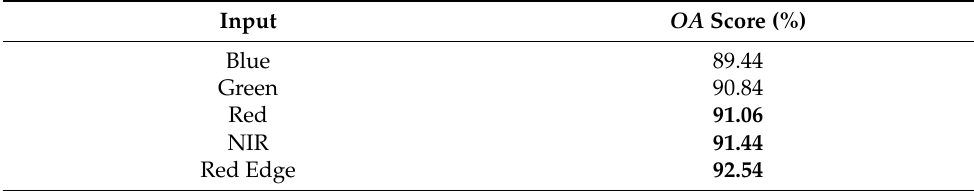
Table 12. Performance with single input of 5 raw bands.